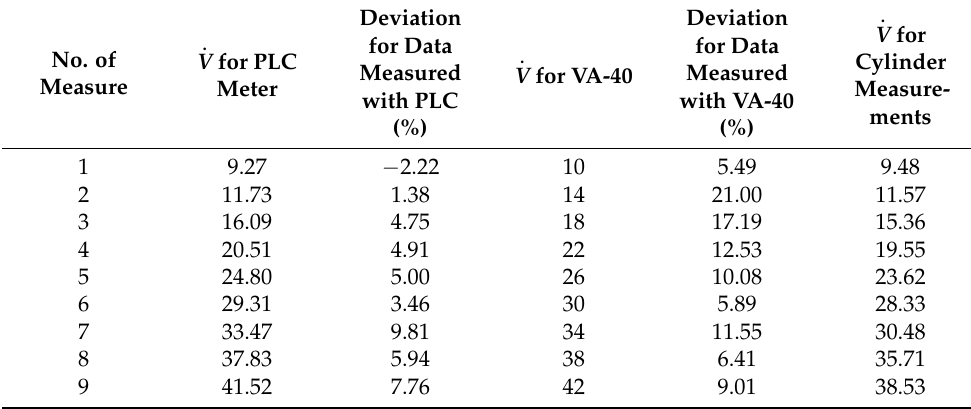
. V is the average flow rate in mL/s.